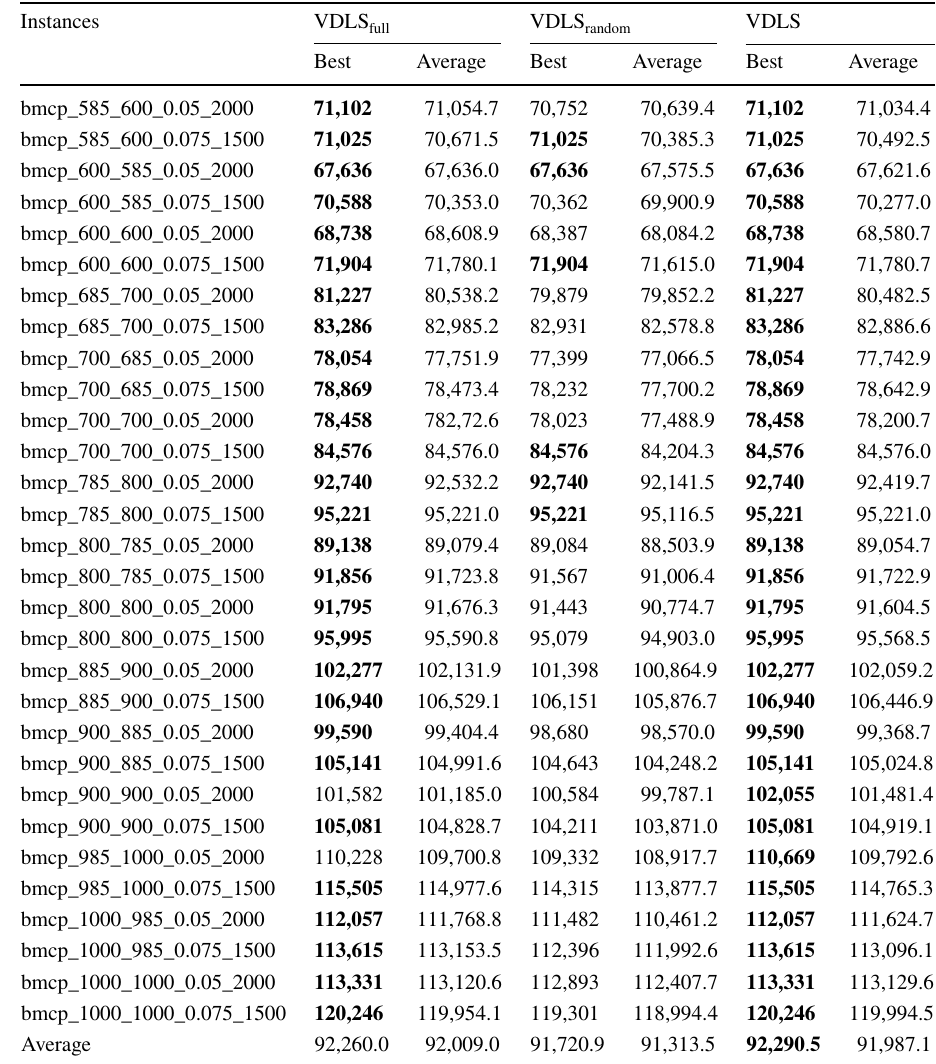
Table 6 Comparison of the VDLS and its variant algorithms, VDLS full and VDLS random , with 30 min of time limit in solving the 30 instances of the first